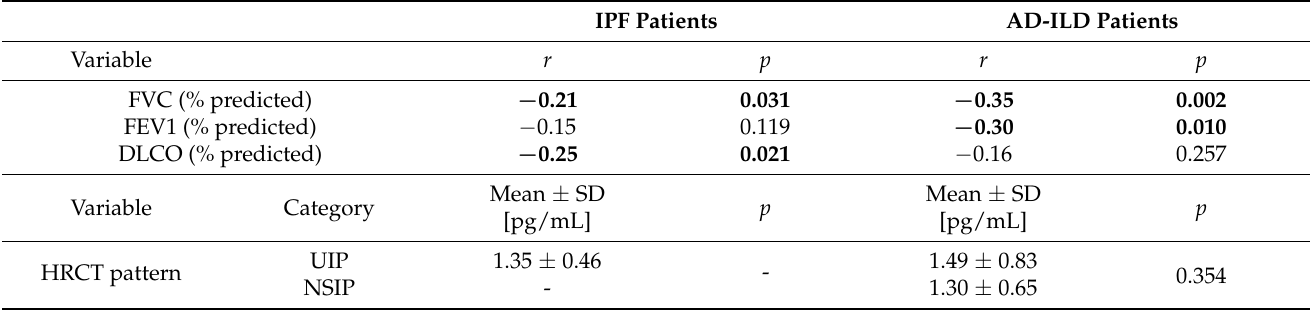
Figure 3. Partial correlation between ET-1 serum levels and FVC ( A ) and DLCO ( B ) in IPF patients. Table 1. Association between ET-1 serum levels and clinical characteristics of the patients included in the study.